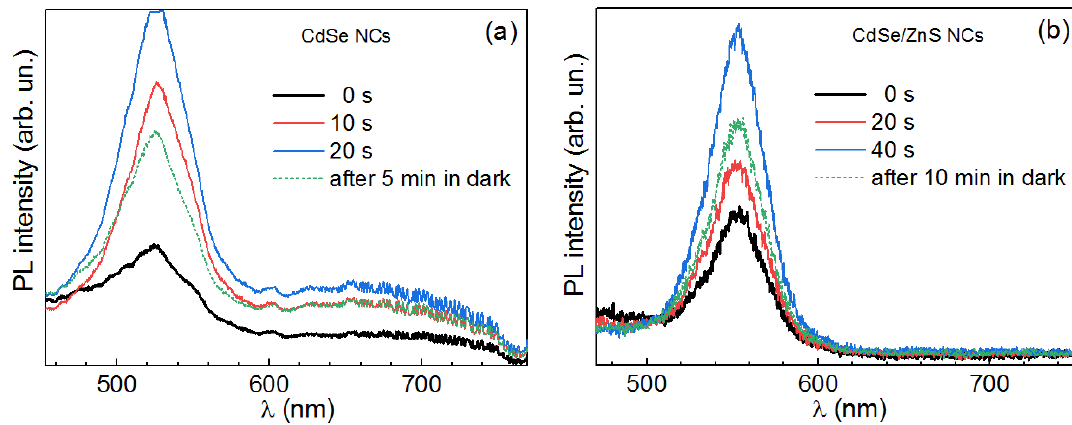
Figure 14. Illustration of the reversibility of the PL photoenhancement for both CdSe ( a ) and CdSe / ZnS NCs ( b ) at λ exc = 325